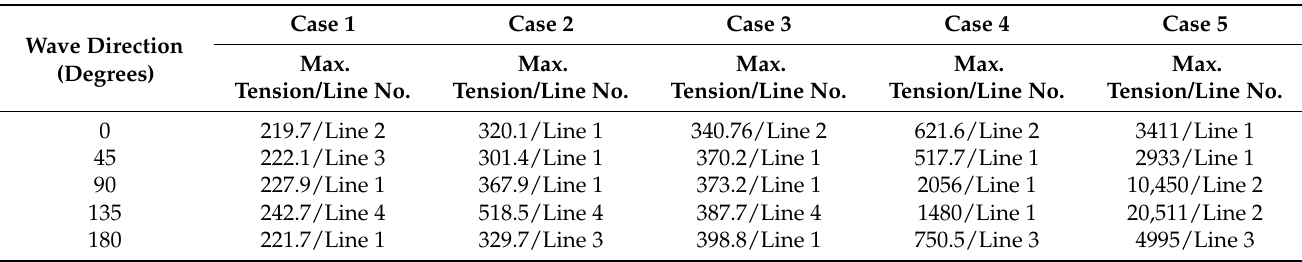
Table 9. Maximum tension (kN) in the mooring lines over a 3 h storm duration and under varied incident wave directions and sea states.